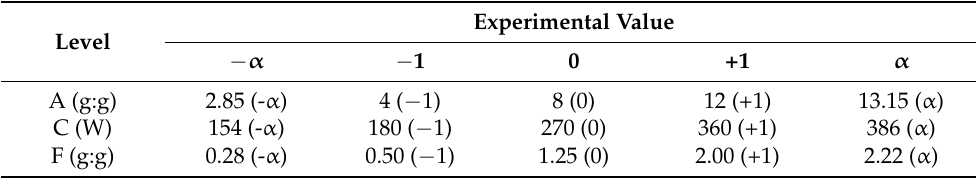
Table 6. CCD for optimization of the three significant factors.